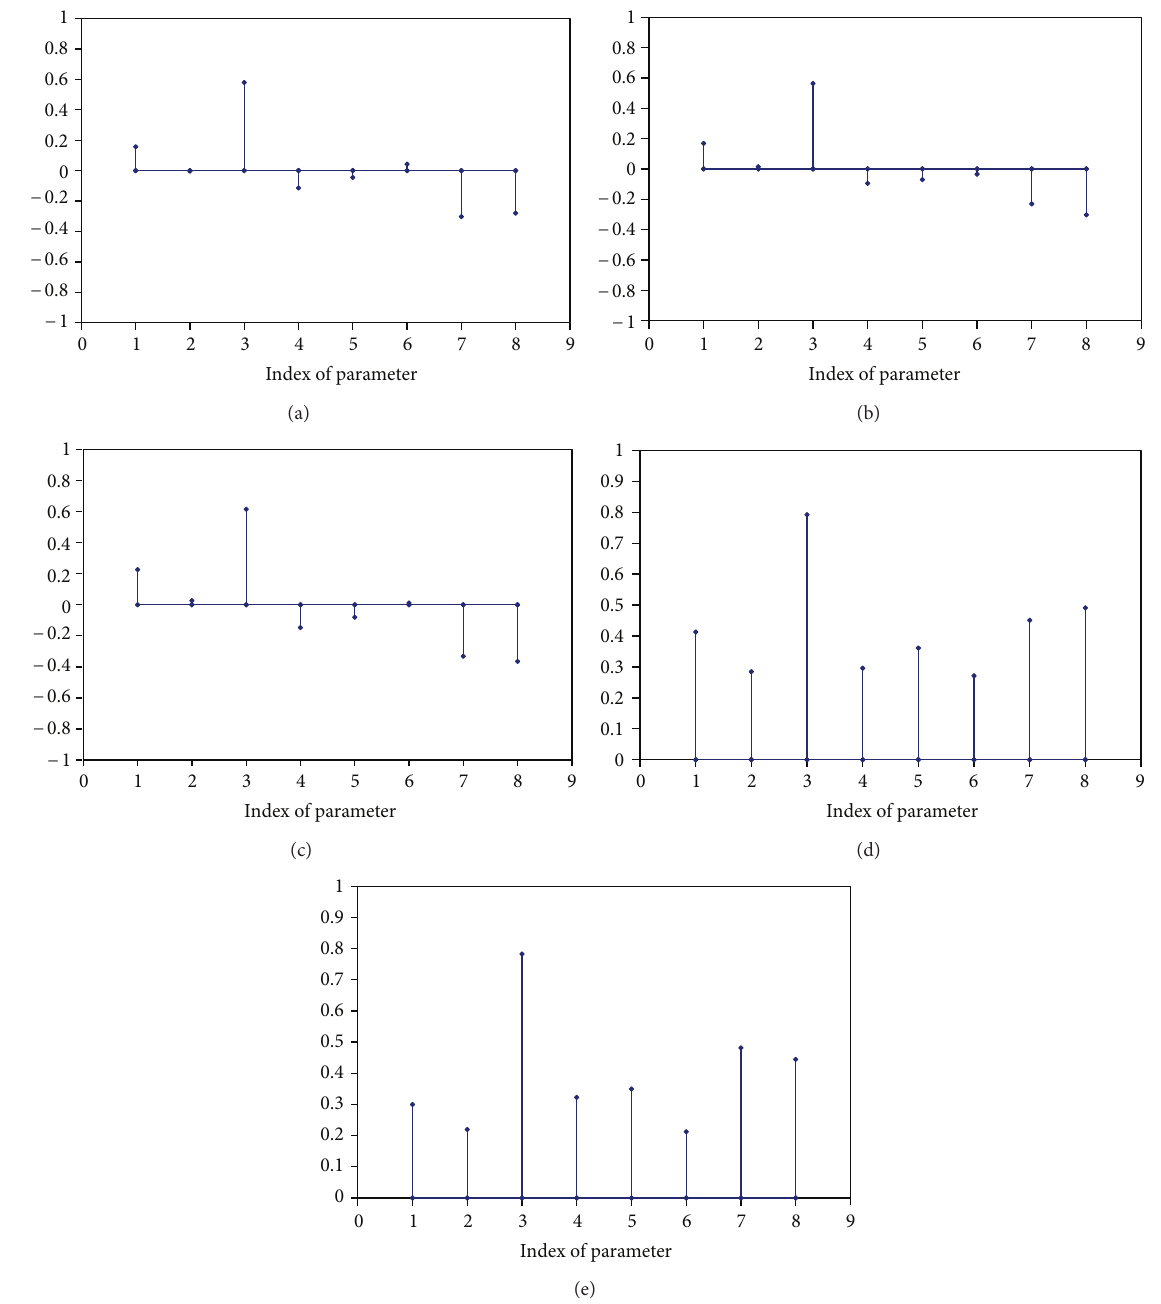
F 14: Kendall rank correlation coefficients for the 100 LHS Uniform (a) and 200 LHS Normal (b) sets. (c) Partial correlation coefficients for the Kendall correlation of the 200 LHS Normal set. Empirical correlation ratios for the 100 LHS Uniform (d) and 200 LHS Normal (e)